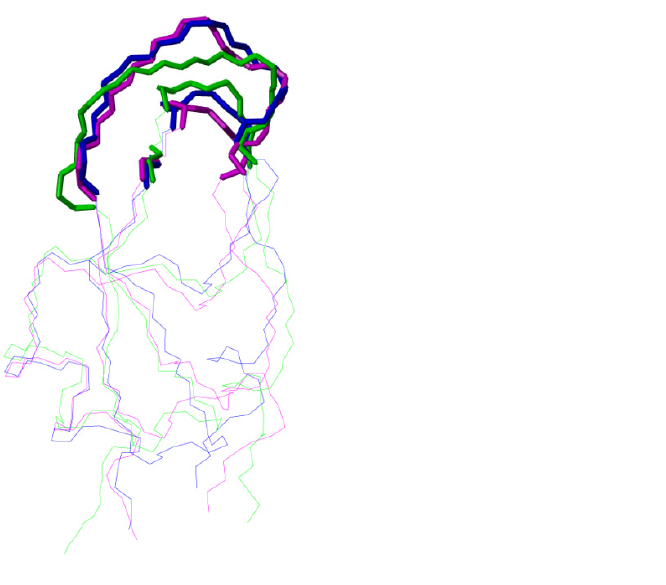
Figure 6. Backbone conformation of residues 11–19, 34, and 36–39 in the trypsin binding loop of BPTI (magenta), and corresponding residues in NACI (blue) and BF9